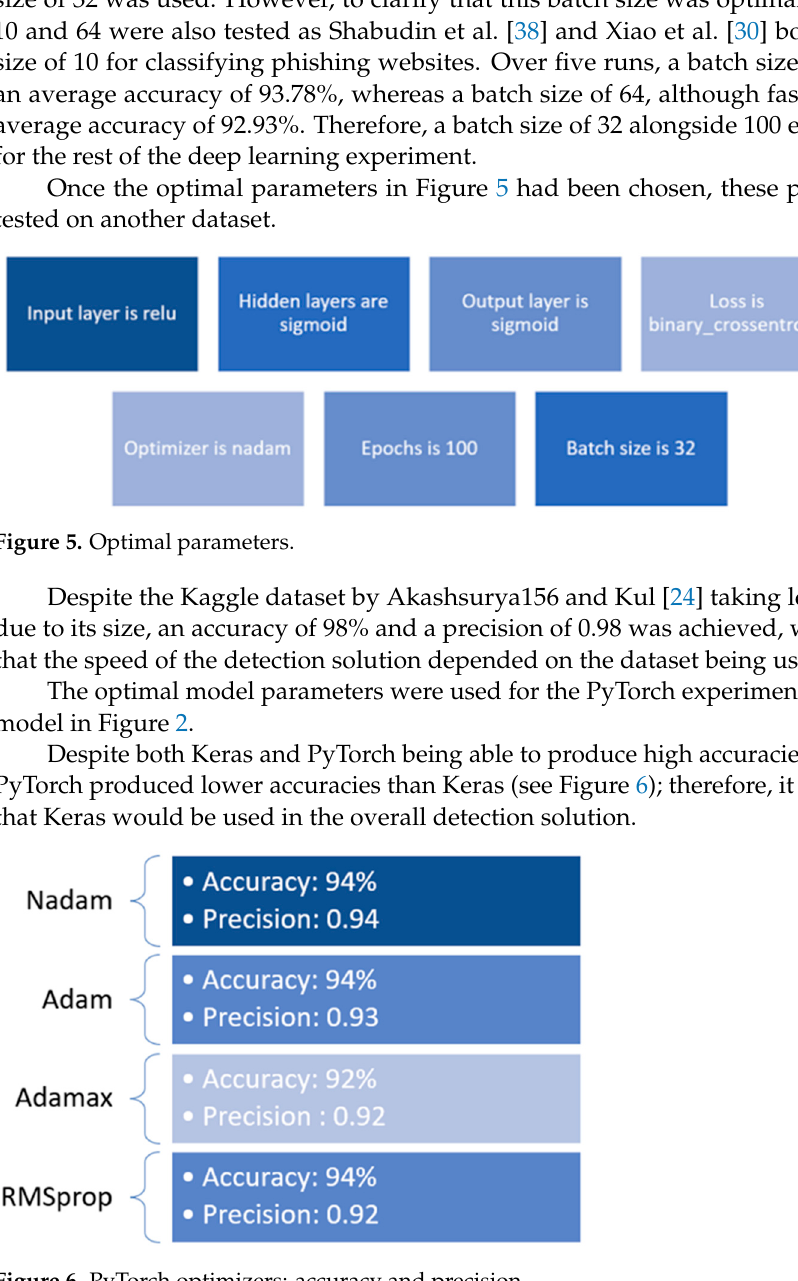
Figure 6. PyTorch optimizers: accuracy and precision.